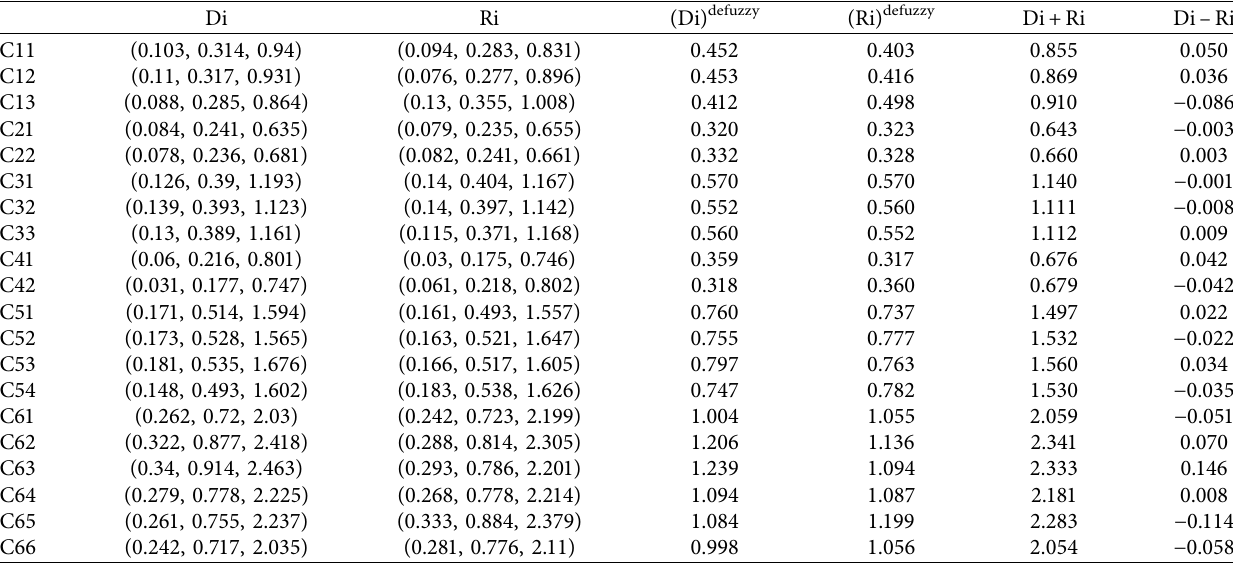
Table 7: T c relational pattern of T c matrix.